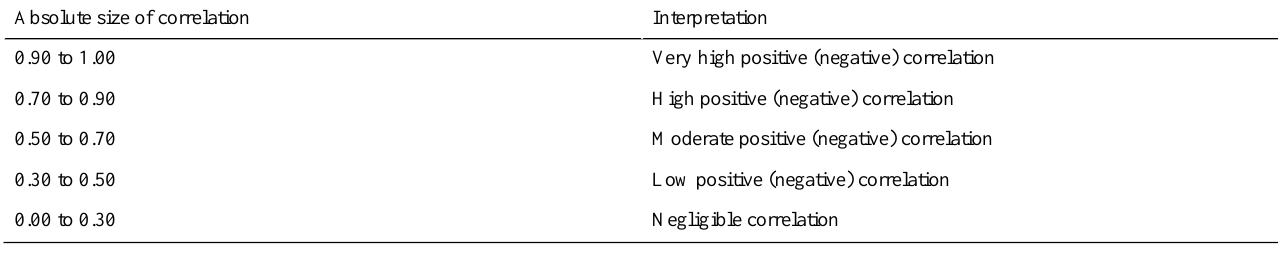
Table 2. Interpreting correlation values.